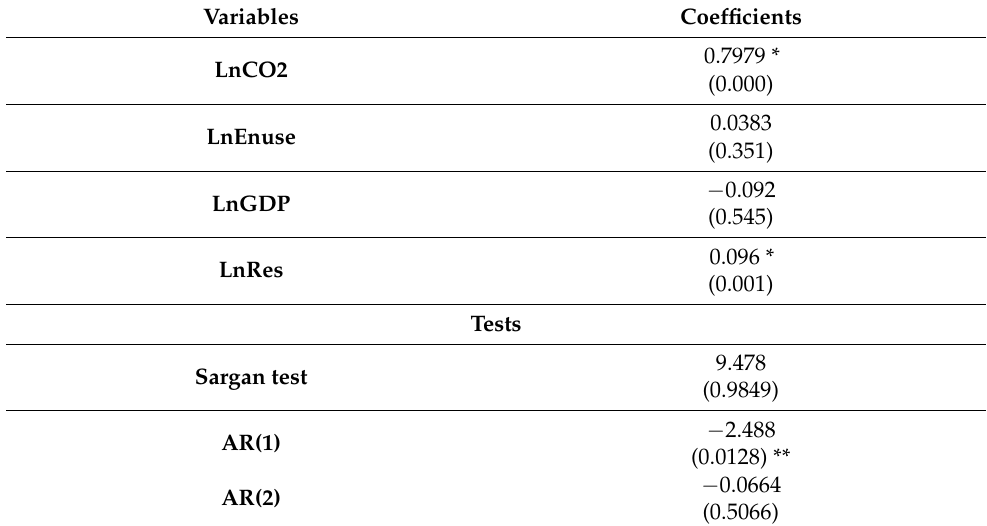
Table 8. Dynamic GMM